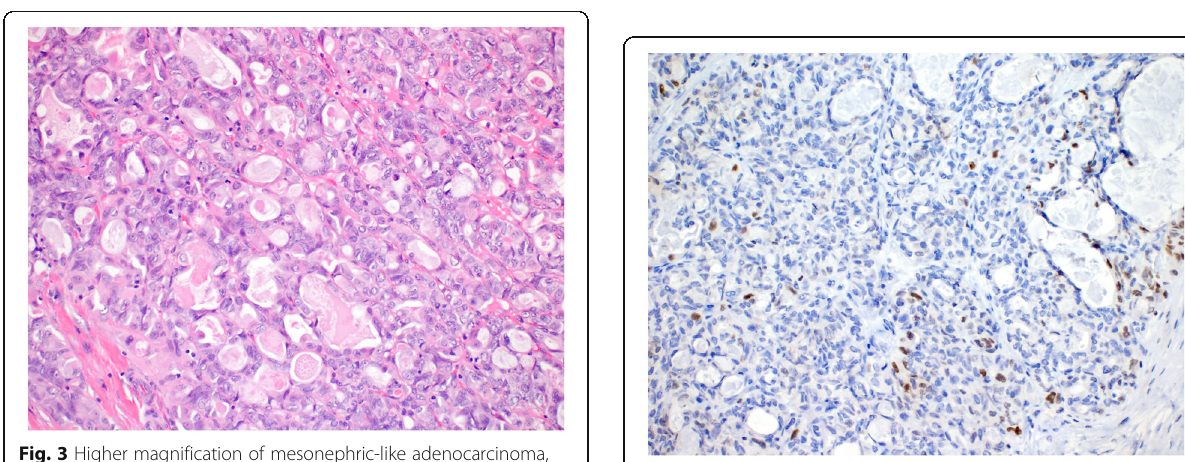
Fig. 5 Mesonephric-like adenocarcinoma showing focal GATA3 staining